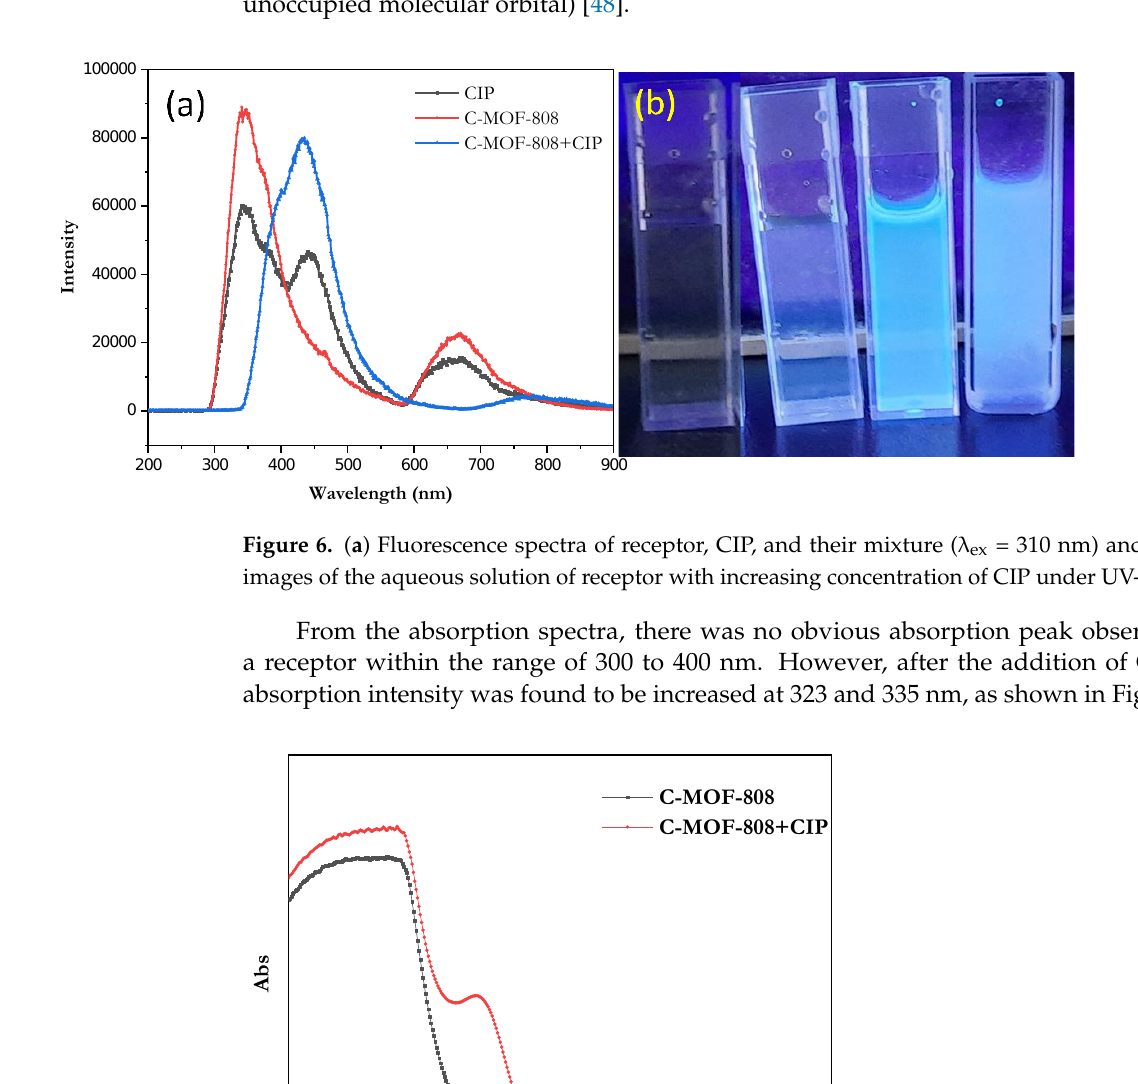
Figure 7. The absorption spectra of receptor and with CIP.